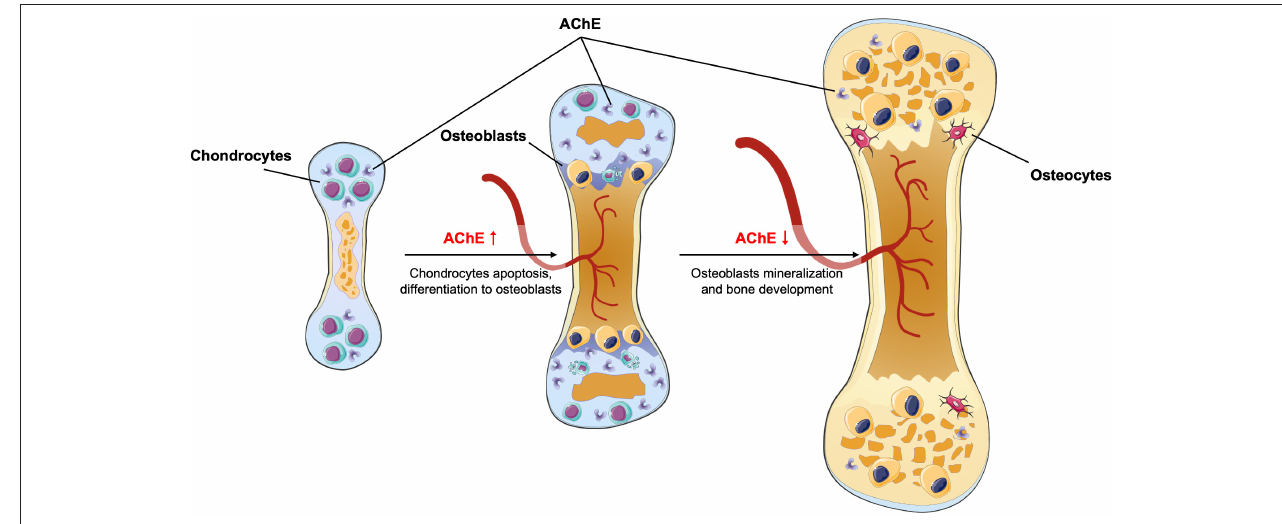
FIGURE 1 | During endochondral ossification, AChE level first increases to favor chondrocytes apoptosis, later AChE level decreases and therefore accelerates bone